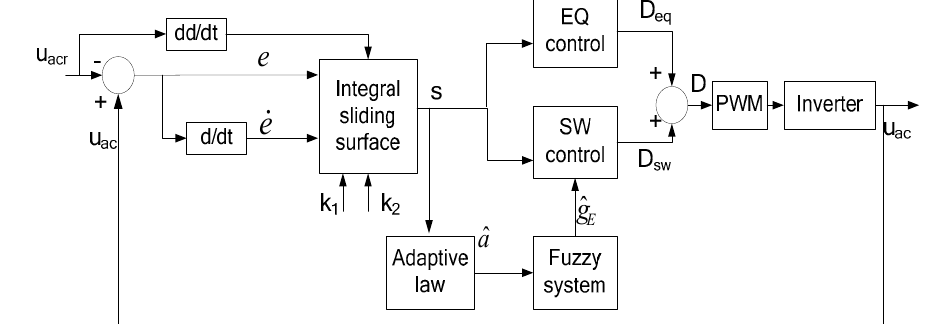
Figure 6. Block diagram of AFSMC.